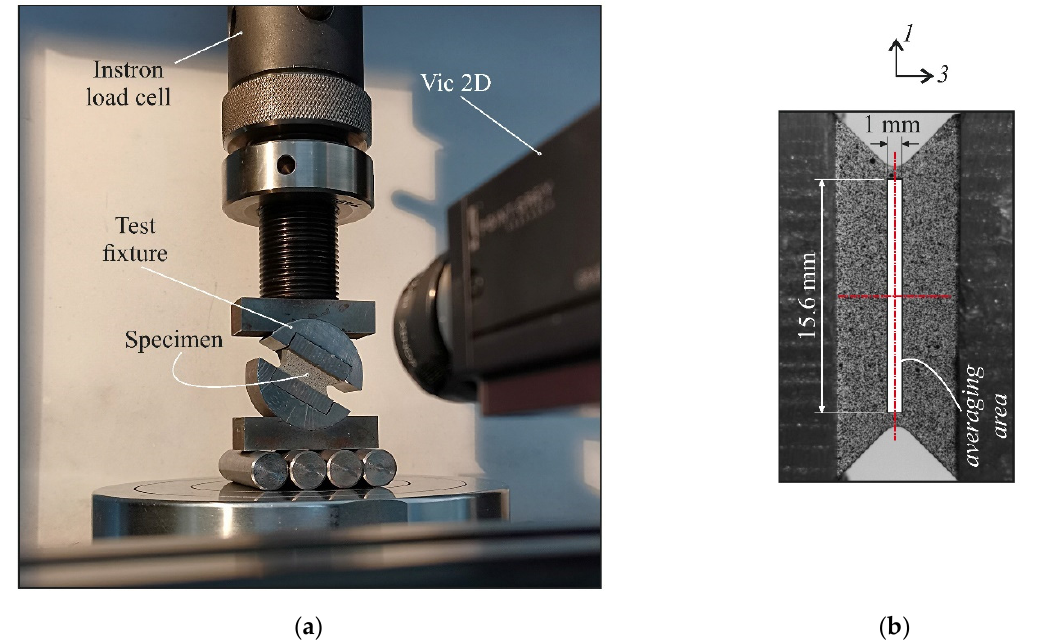
Figure 5. Experimental setup for testing under combined loading ( a ); specimen and strain averaging area ( b ).